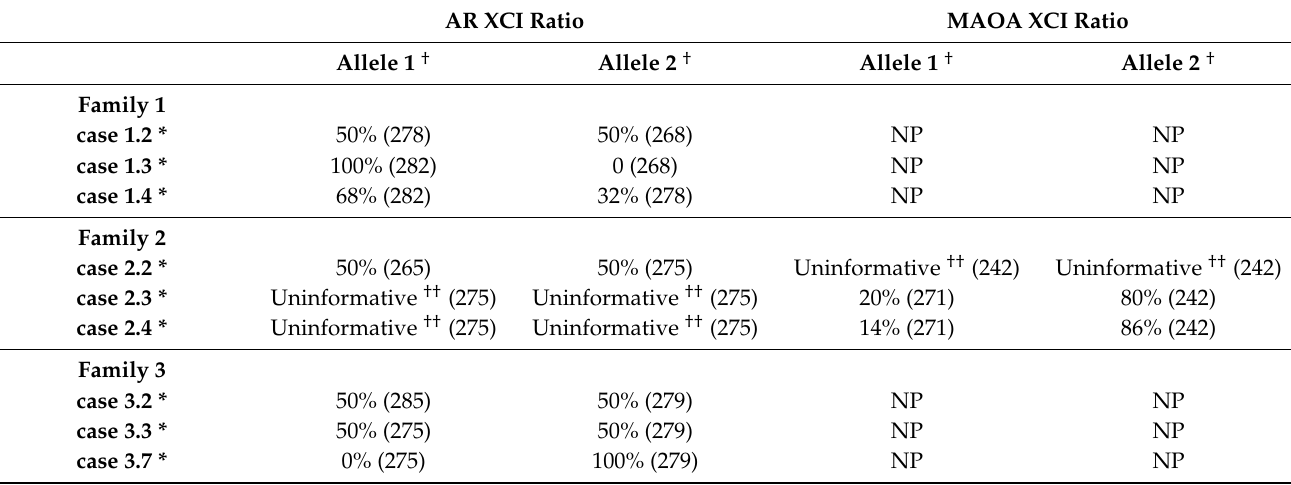
Table 1. The X-chromosome inactivation (XCI) patterns in female members of families 1, 2, and 3. Skewed XCI is evidenced in the three patients (case 1.3. 2.3, and 3.7) and two unaffected females (case 1.4 and 2.4), all showed unequal methylated degree between the two alleles of androgen receptor (AR), or monoamine oxidase A (MAOA) locus. Nonmethylation of the maternal allele was demonstrated in one patient (case 1.3: 0%). Hypomethylation, or nonmethylation of the paternal allele was evidenced in two patients (case 2.3: 20% and case 3.7: 0%). AR XCI Ratio MAOA XCI Ratio Allele 1 † Allele 2 † Allele 1 † Allele 2